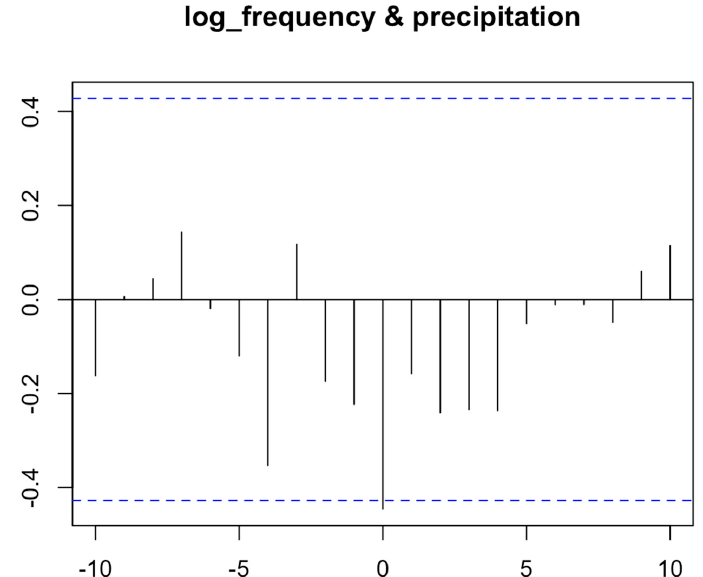
Figure 5. Cross correlation results from precipitation and log of the sum of tweets under topic 1, 2, 6, or 7. Note: This figure is interpreted in the same way as Figure 3, described above, where “Lag” on the horizontal axis refers to the number of time points that are different between A and B (log_frequency and precipitation, respectively). The black vertical line shows correlation between B at time x and A at time (x + lag), and the blue horizontal dash indicates the threshold of significance. If a black vertical line is taller than the blue horizontal dash, the correlation between A and B at that lag is considered statistically significant. The topics refer to the following: 1 (“ Lake save future ”), 2 (“ Conserve government waste ”), 6 (“ Pond rainwater nature ”), and 7 (“ Tap world important